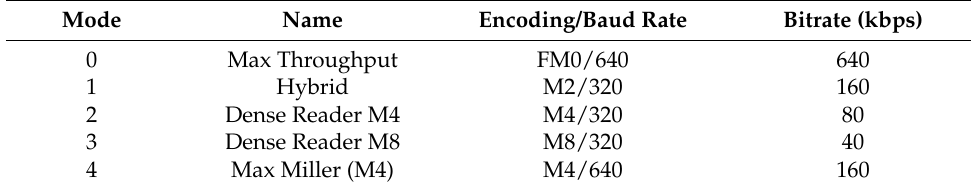
Table 1. Standard modes of Impinj speedway